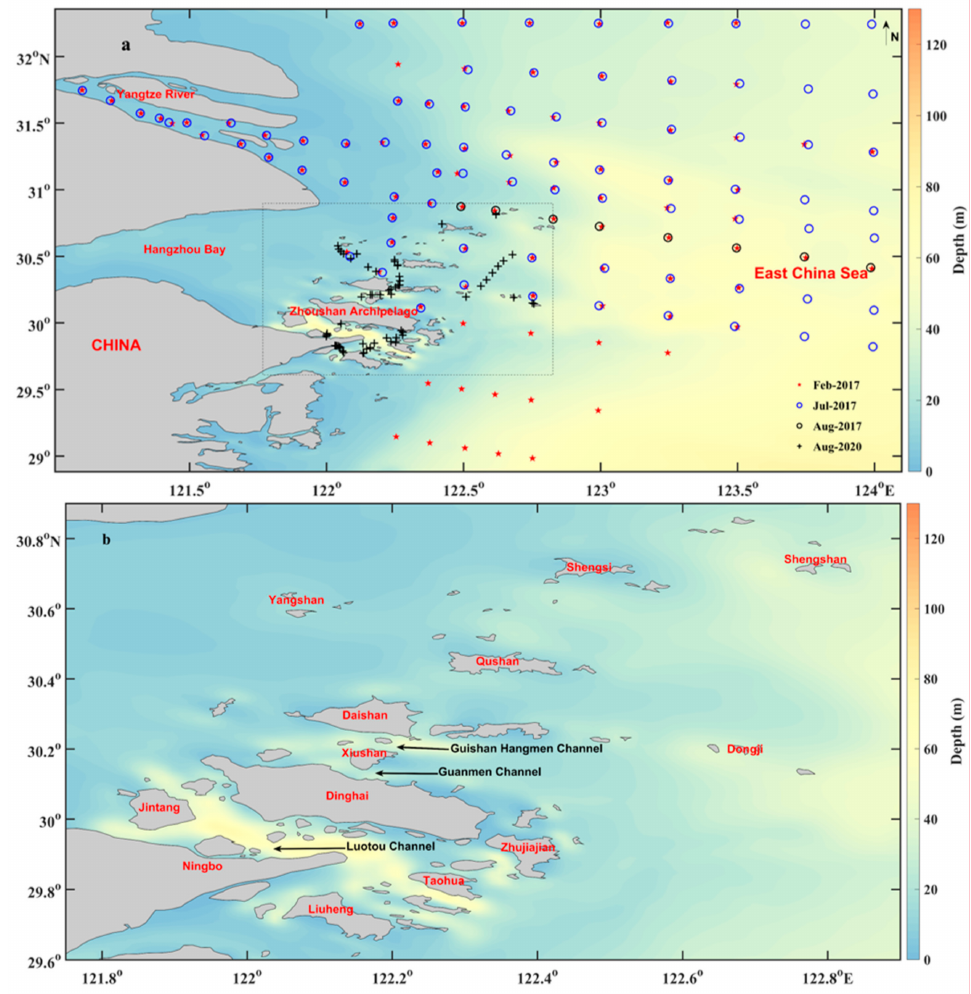
Figure 1. ( a ) Geographic location of the Zhoushan Archipelago and locations of the sampling stations during four cruises (Feb-2017, Jul-2017, Aug-2017, and Aug-2020). ( b ) Bathymetry map of the study area.